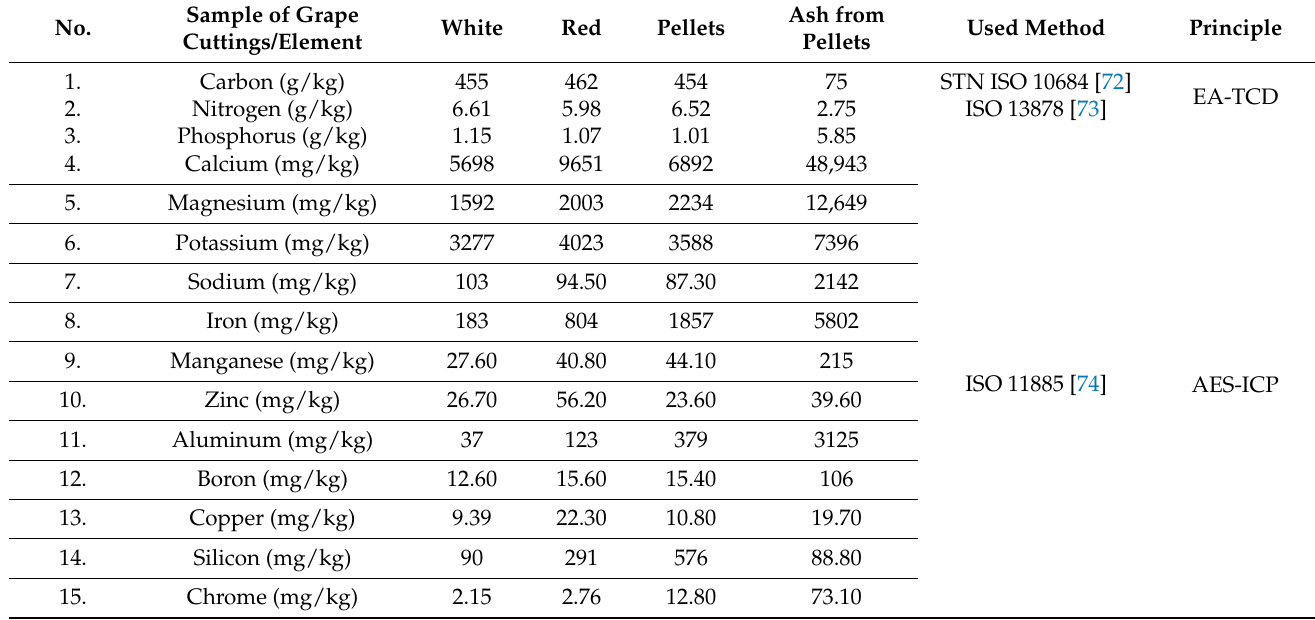
Table 3. The elemental analysis and ash content of grape